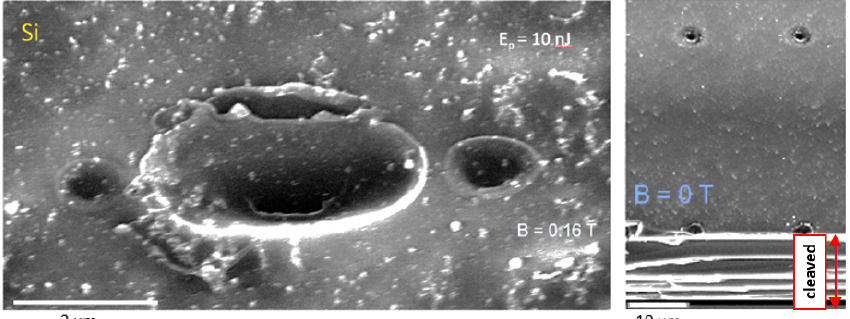
Figure A2. 45 ◦ Slanted-view SEM image of the ablation sites made by E p = 10 nJ energy single pulse (objective lens NA = 0.7, T = 0.22) with magnetic field and without. The linear pattern of micro-ablation pits is aligned in the B-field